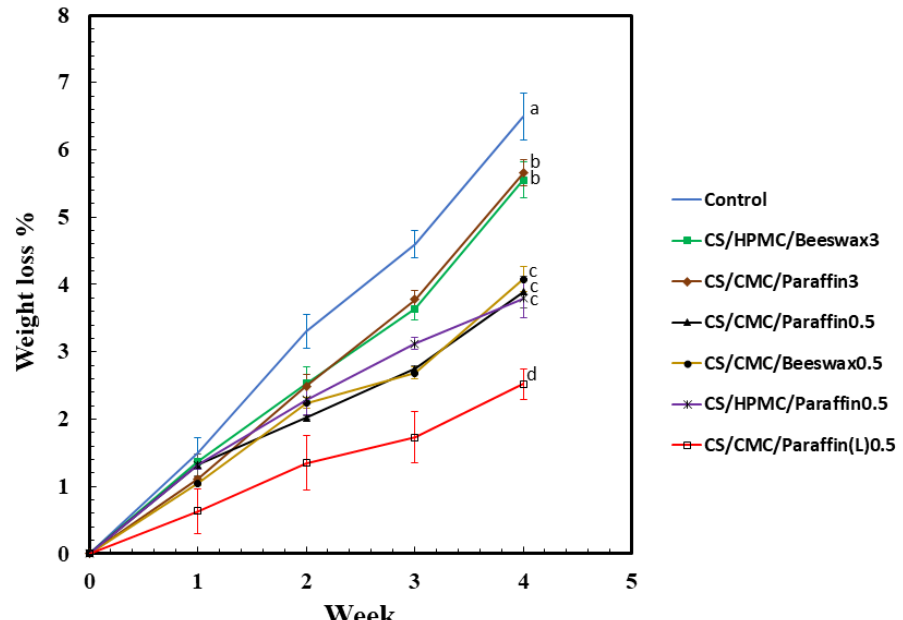
Figure 3. Variation in weight loss (%; n = 5) of eggs coated with cassava starch (CS) blended with hydroxypropyl methylcellulose (HPMC), carboxymethyl cellulose (CMC), beeswax, paraffin, and low ‐ molecular ‐ weight paraffin wax (Paraffin(L)) during 4 weeks of storage at 25 ± 3 °C and 65 ± 2% relative humidity. The control indicates uncoated eggs. Means with different lowercase superscript letters were significantly different ( p < 0.05).